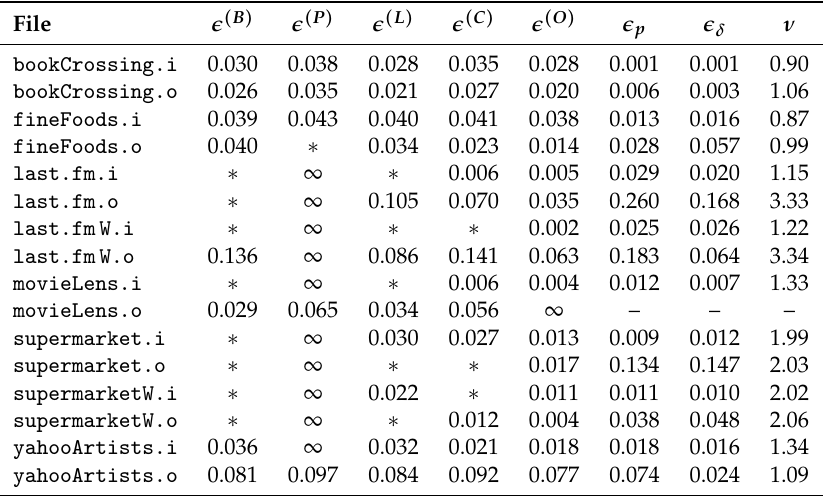
Table 5. Errors and attachment exponents for bipartite